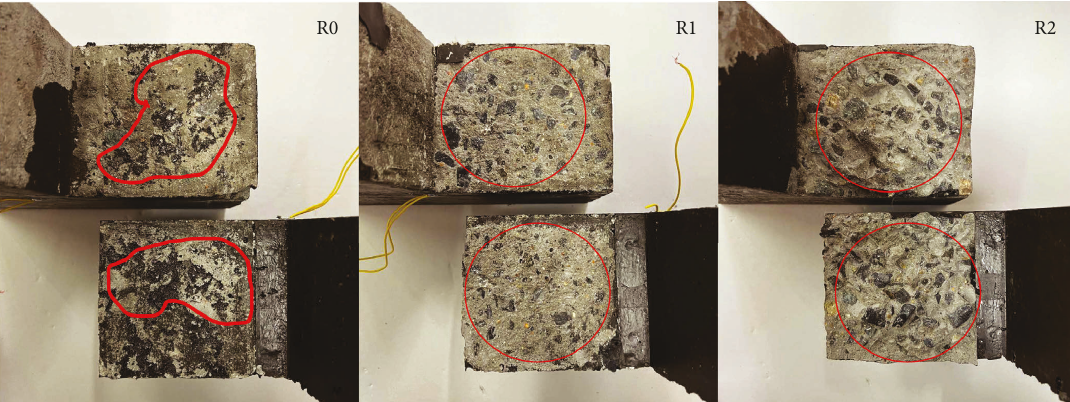
Figure 26: Bond direct shear damage